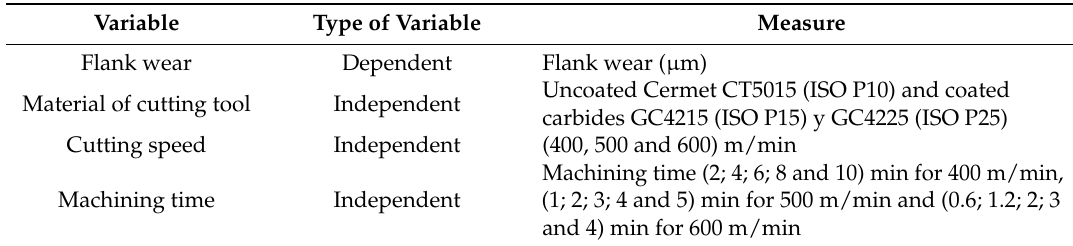
Table 3. Cutting conditions of